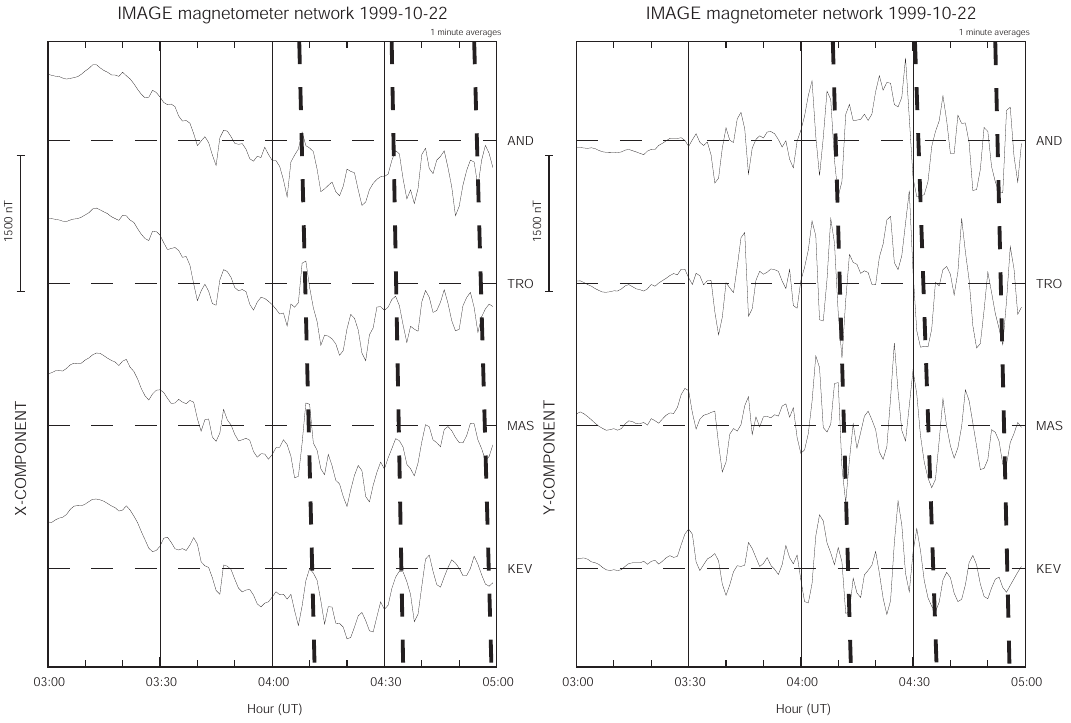
Fig. 4. Magnetograms of X and Y components from the longitudinal chain of IMAGE magnetometers (west to east, from AND to KEV) on 22 Oct 99 displayed in Fig. 3 (samples 4–12). Some sharp features on the magnetograms are connected with the dashed line to show the eastward phase motion. Quasi-periodic magnetic variations with T ∼ 8min were observed after 04:00UT.